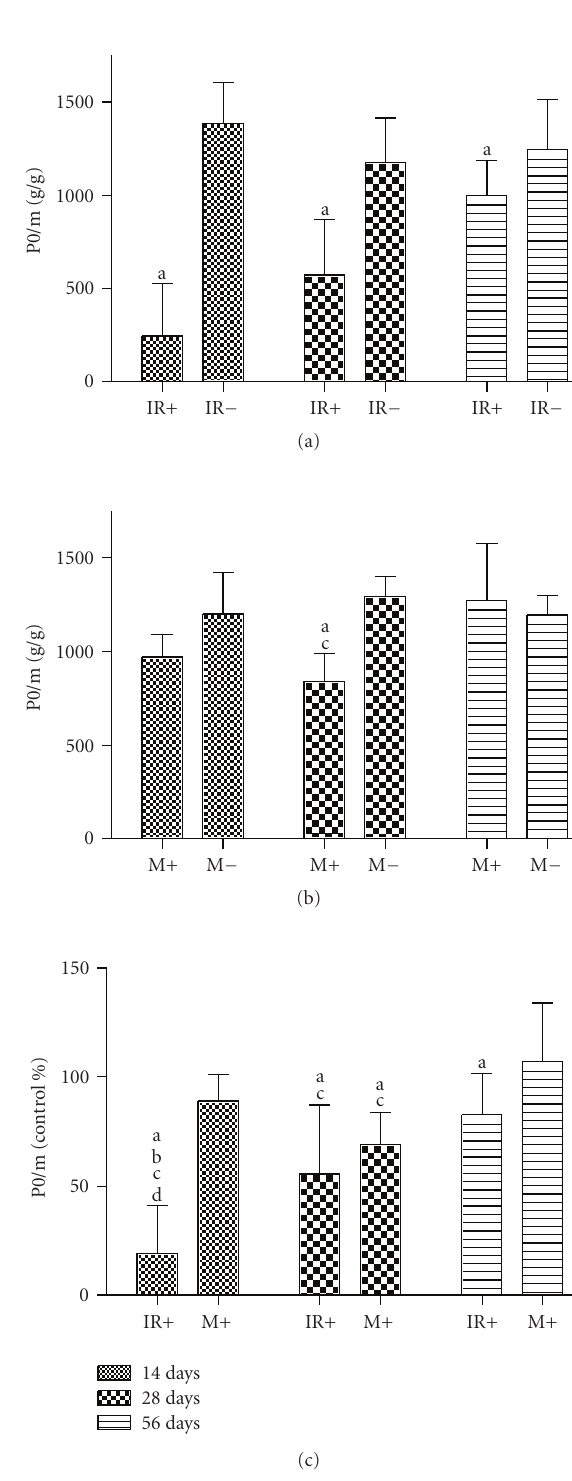
Figure 2: Maximal tetanic force (P 0 ) of muscles after ischemia- reperfusion injury and myotoxic injury. Values are means ± SEM. Number of data per group is 4–6. IR+: ischaemic/reperfused muscles, IR − : control muscles of ischaemic/reperfused muscles, M+: myotoxin-treated muscles, M − : control muscles of myotoxin- treated muscles. (a) significantly di ff erent from control ( P < . 05), (b) significantly di ff erent from 28 days ( P < . 05), (c) significantly di ff erent from 56 days ( P < . 05), (d) significantly di ff erent from M+.